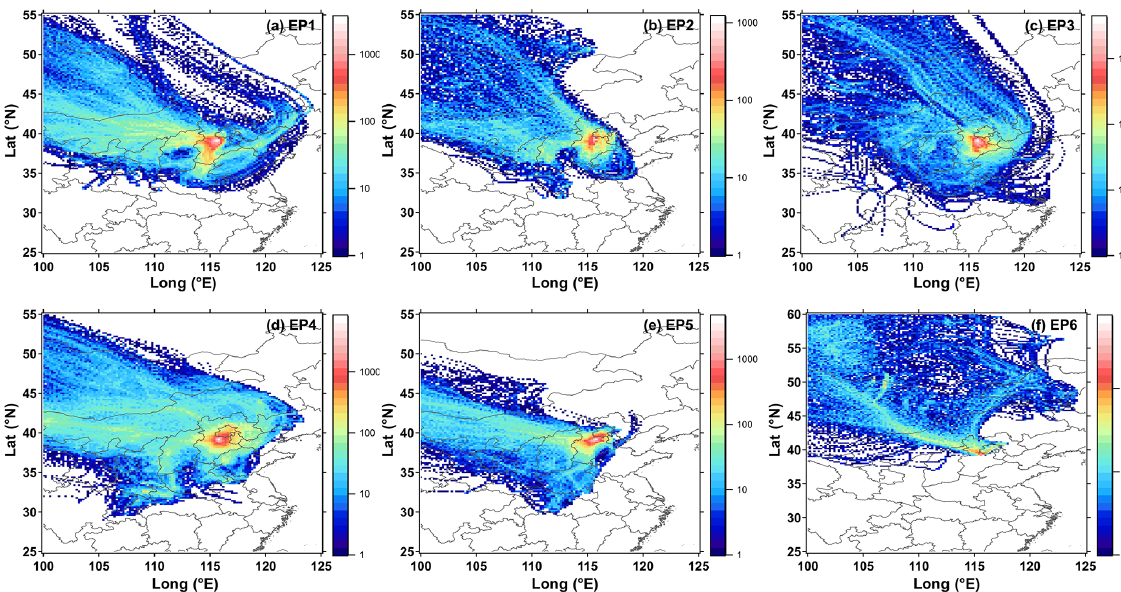
Figure 2. The backward trajectories from which the air mass over GC originated in varying periods.